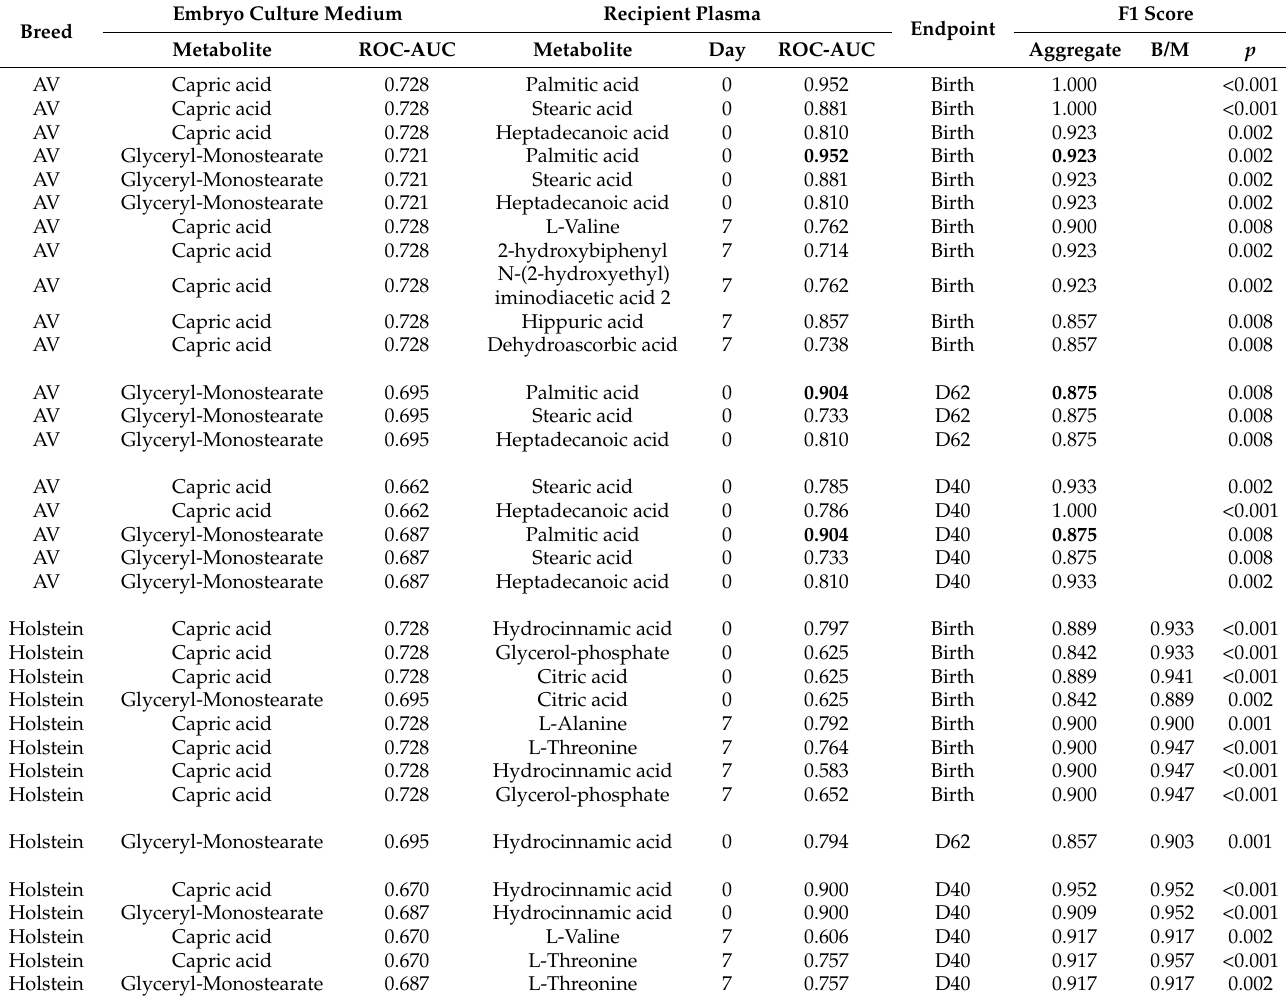
Table 4. Pairs of single biomarker metabolites in the embryo culture medium and plasma (Day-0 or Day-7) predict pregnancy at the indicated endpoints and within recipient breeds (AV: Asturiana de Valles, Holstein) by calculation of F1 scores within aggregate (Day-6 embryonic stages not considered) or B/M (Day-6 separate blastocyst and morula stages